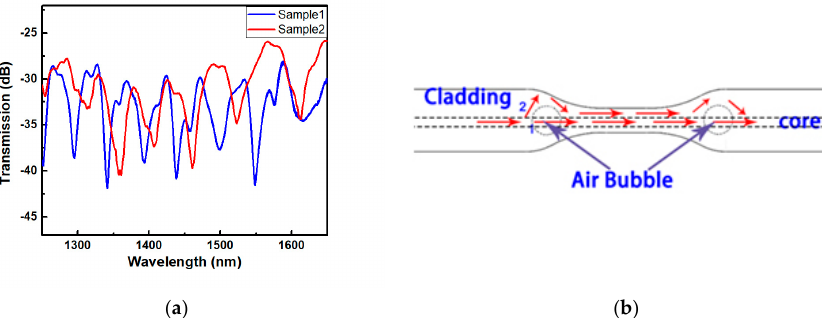
Figure 3. ( a ) Transmission spectra of two samples with different dimensions; ( b ) the principle of light transmission in the fiber.